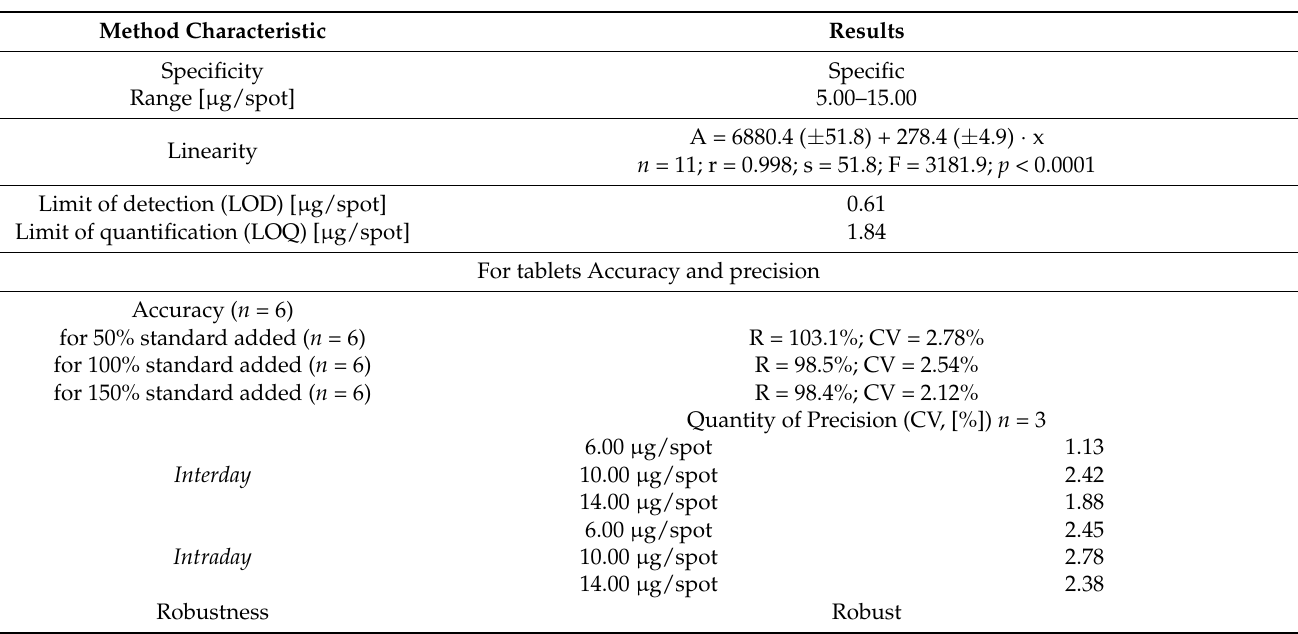
Table 5. Method validation data for the quantitative determination of diclofenac sodium by NP-TLC with densitometry after 2D separation using two mobile phases: first chloroform–methanol–ammonia (36:4:0.60 v / v / v ) and second cyclohexane–chloroform–methanol–glacial acetic acid